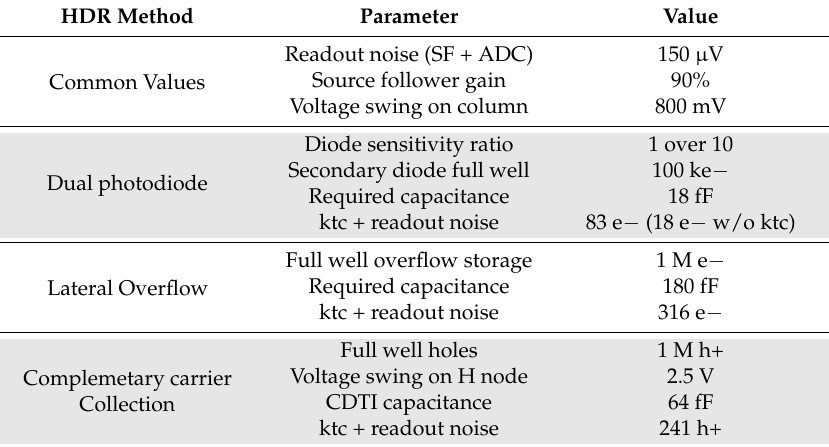
Table 2. Model input and associated temporal noise.